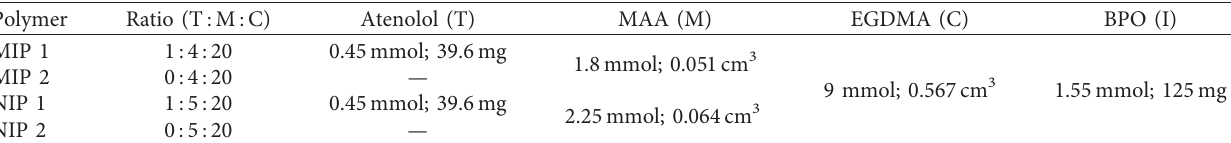
Table 1: Materials composition of the imprinted monolithic columns.